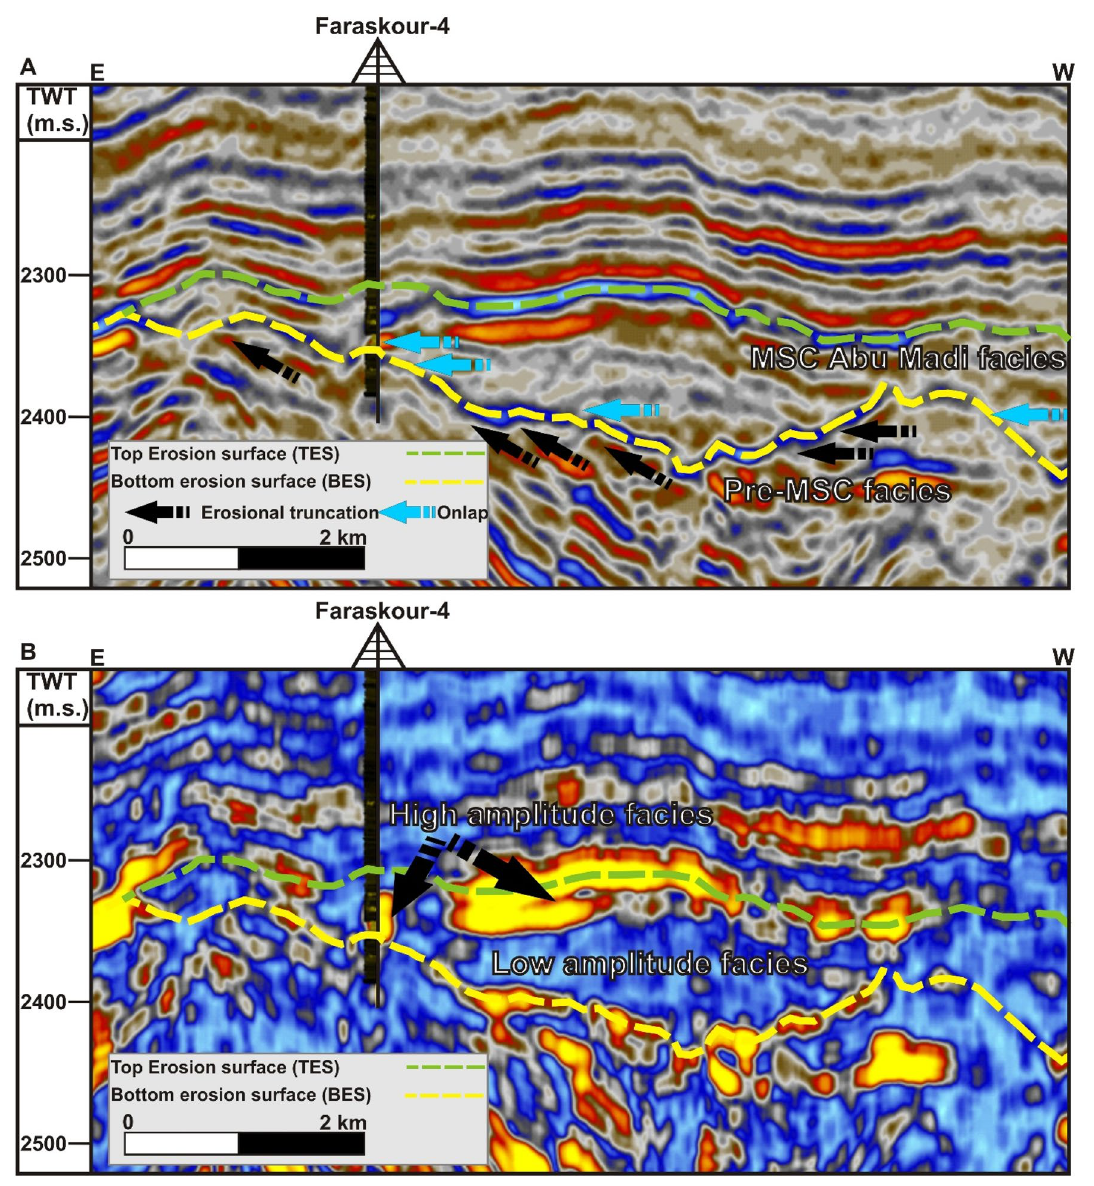
Fig. 5 Interpreted E-W seismic section in original amplitude ( a ) and RMS amplitude attribute ( b ) illustrating the Abu canyon and its MSC-infill facies (see location in Fig.